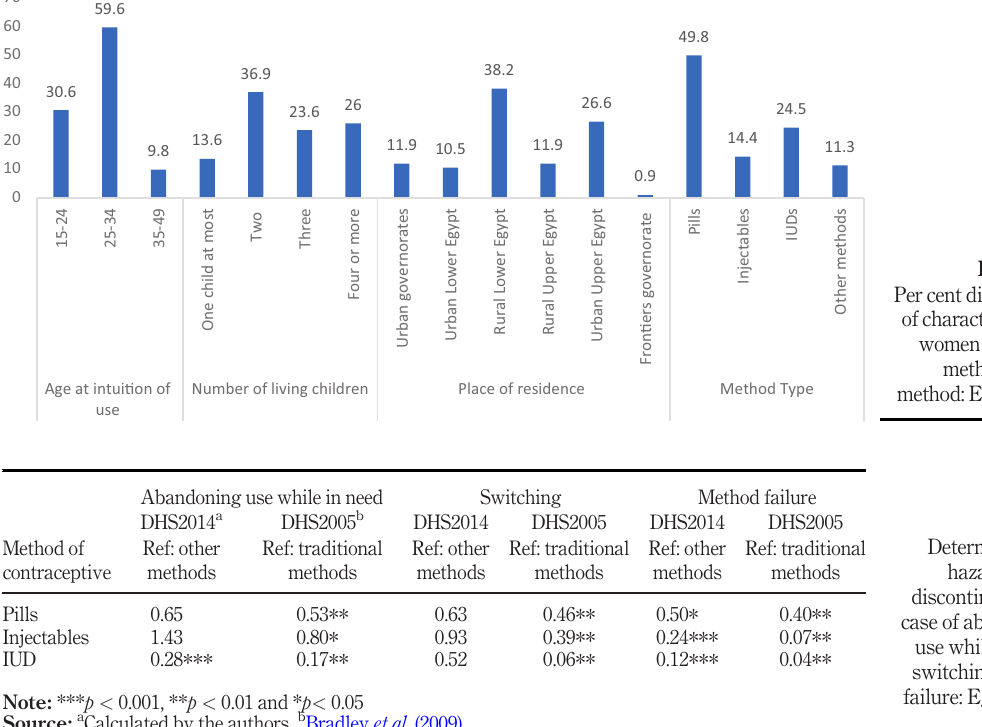
Table 3. Determinants